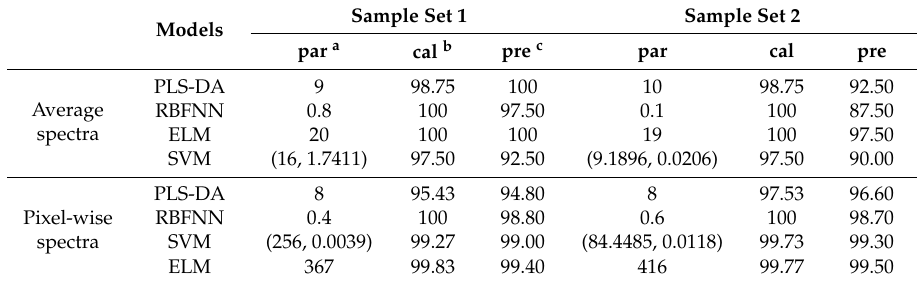
Table 1. Results of discriminant models using full spectra and pixel-wise spectra of sample set 1 and 2.